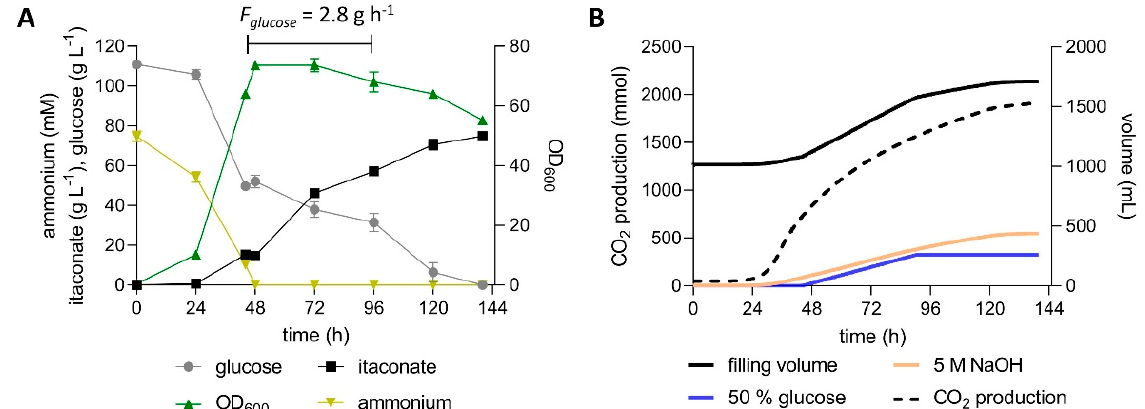
Figure 6. High-density fed-batch fermentation with continuous feed of U. maydis strain K14. ( A ) concentration of glucose, itaconate and ammonium, and OD 600 values and ( B ) filling volume, CO 2 production and the added volumes of 5 M NaOH and 50% glucose during fermentation in a bioreactor containing batch medium with 120 g L − 1 glucose and 4 g L − 1 NH 4 Cl. The pH was kept at 6.5 by automatic titration with NaOH. Cultures were fed with an additional 130 g glucose at a rate of 2.8 g h − 1 during the indicated time interval. Error bars indicate the deviation from the mean ( n = 2).